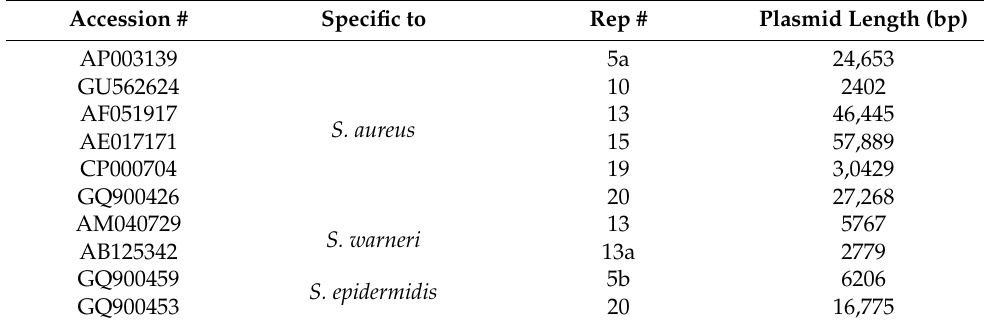
Table 2. List of considered plasmids in this